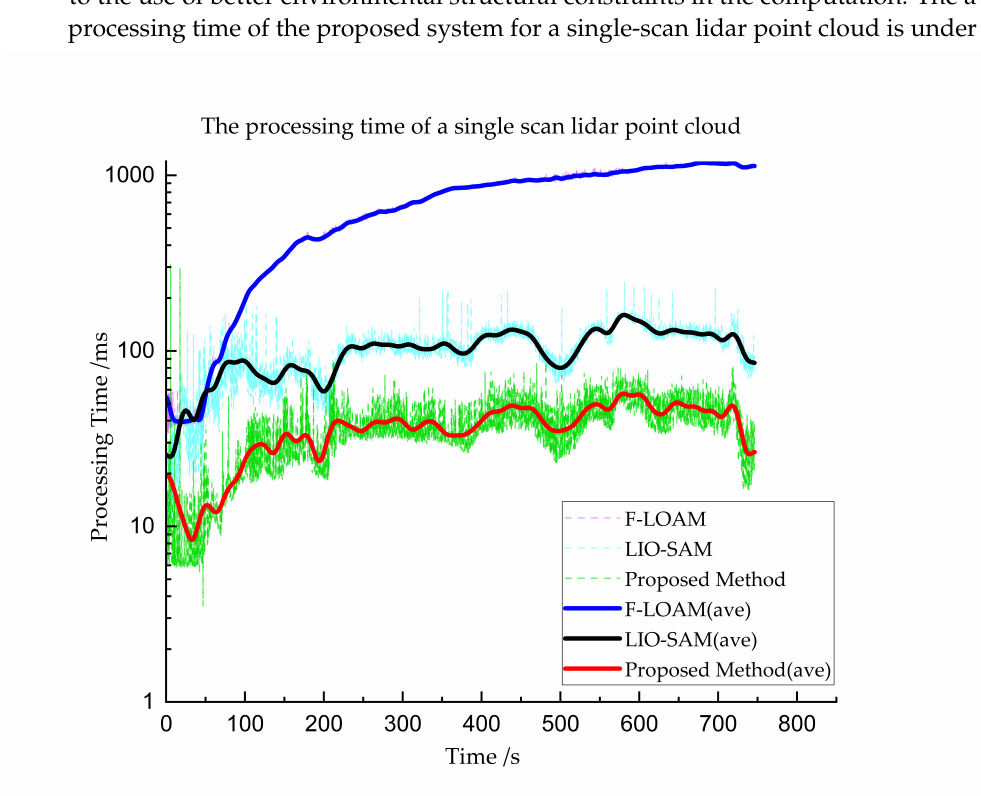
Figure 11. The processing time of a single-scan lidar point